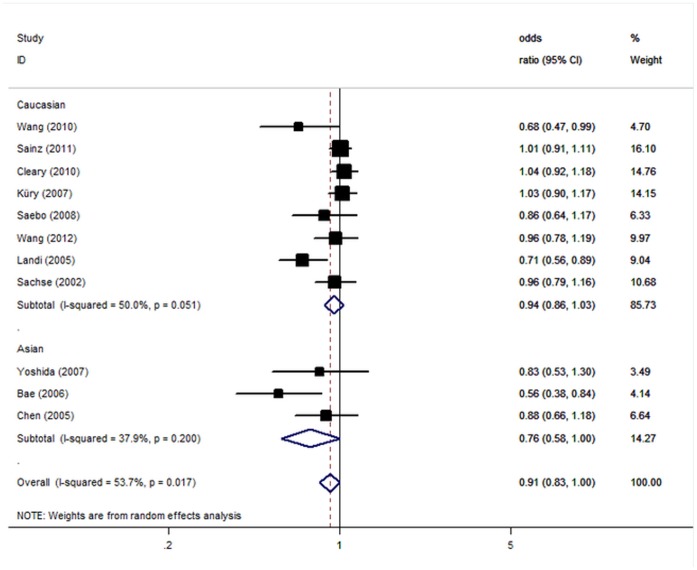
Forest plot from the meta-analysis of CYP1A2*F polymorphism and CRC risk.